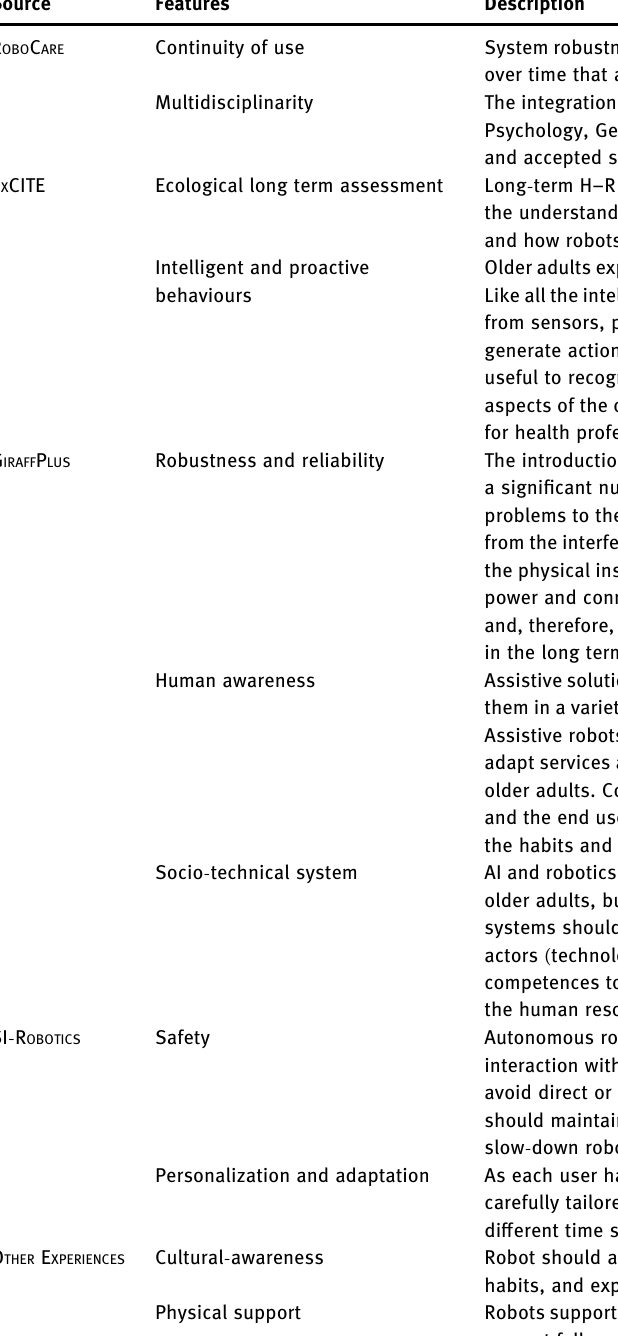
Table 3: Discussion of lessons learned from